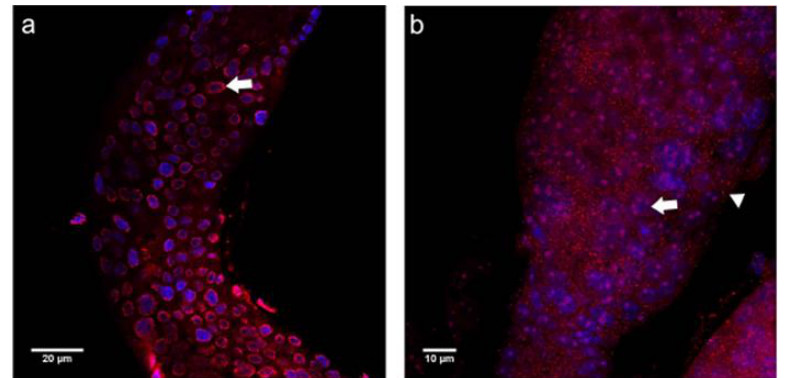
Figure 7. Immunolocalization performed on testes of drone larvae with antibodies raised against the N- and C-terminal domains of E- and N-cadherin. Shown are single confocal section images of 1 (cid:541) m thickness. ( a ) N-cadN appeared more concentrated in the perinuclear region (arrow) of all cells along the testioles. ( b ) In the basal region of testioles, N-cadC appeared dispersed throughout the cytoplasm (arrowhead) and as large nuclear foci (arrow). ( c ) In the basal region of testioles, E-cadN was detected in the cytoplasm (arrowhead) and as nuclear foci (arrow) in all cells. ( d ) E-cadC was detected in the center of cystocyte rosettes in colocalization with the fusomes (arrowhead). Cadherin immunoreactivity is shown in red, counterstained nuclei are in